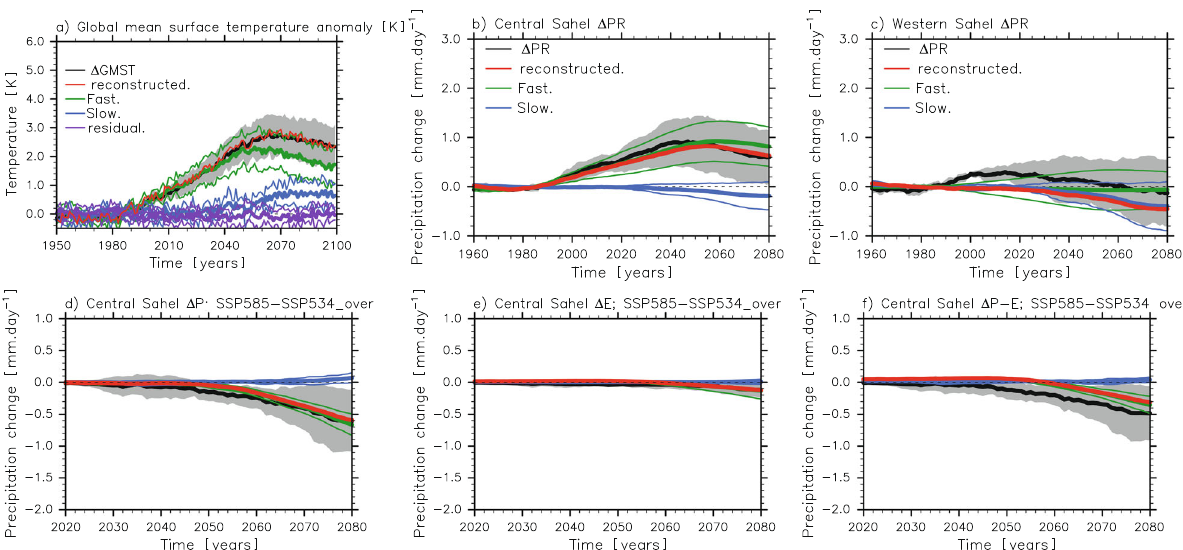
Fig. 4 A mitigation strategy. a Multi model mean contribution of the fast (green) and slow (blue) response to the global mean surface temperature warming (K) in SSP534_over (black) (thick line). Residual is given by the purple line and the reconstruction (fast + slow) by the red line. Grey shading (thin lines) indicates the inter model spread, de fi ned from each model, for the SSP534_over response (fast, slow and residual responses). b Multi model mean change in central Sahel precipitation (mm day − 1 ), for SSP585 response (black), fast (green), slow (blue) and reconstructed (red) responses. c as in b but for western Sahel and eastern Atlantic Ocean. SSP534_over – SSP585 difference in d precipitation, e evaporation and f P-E for central Sahel. High-frequency variability anomalies are fi ltered-out with a 21-year running mean. 7 models were available for the SSP534_over emissions scenario. 7 models are used for the SSP534_over – SSP585